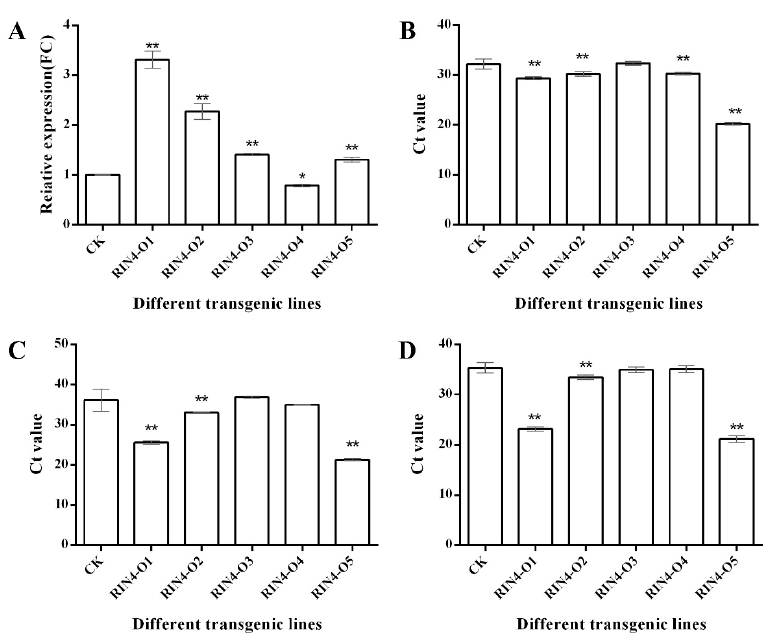
Figure 5. Expression of RIN4 ( A ) and C Las titers ( B – D ) in transgenic plants. FC: fold change. The C Las titters in non-transgenic control and RIN4 -overexpression transgenic pomelo trees were detected at 1, 2 and 3 mpi, respectively ( B – D ). The results were shown as average Ct values of three technical repetitions. mpi: months post inoculation. CK: non-transgenic control plants. RIN4-O1~ RIN4-O5: five different RIN4 -overexpression transgenic lines. The results were shown as mean ± standard deviation (SD). * and ** indicate significant changes at p < 0.05 and p < 0.01, respectively.